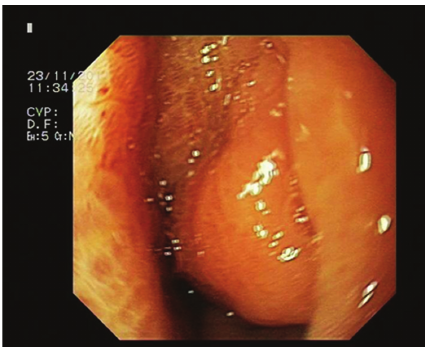
Figure 4: Laparoscopy: extraction of the foreign body from gastric